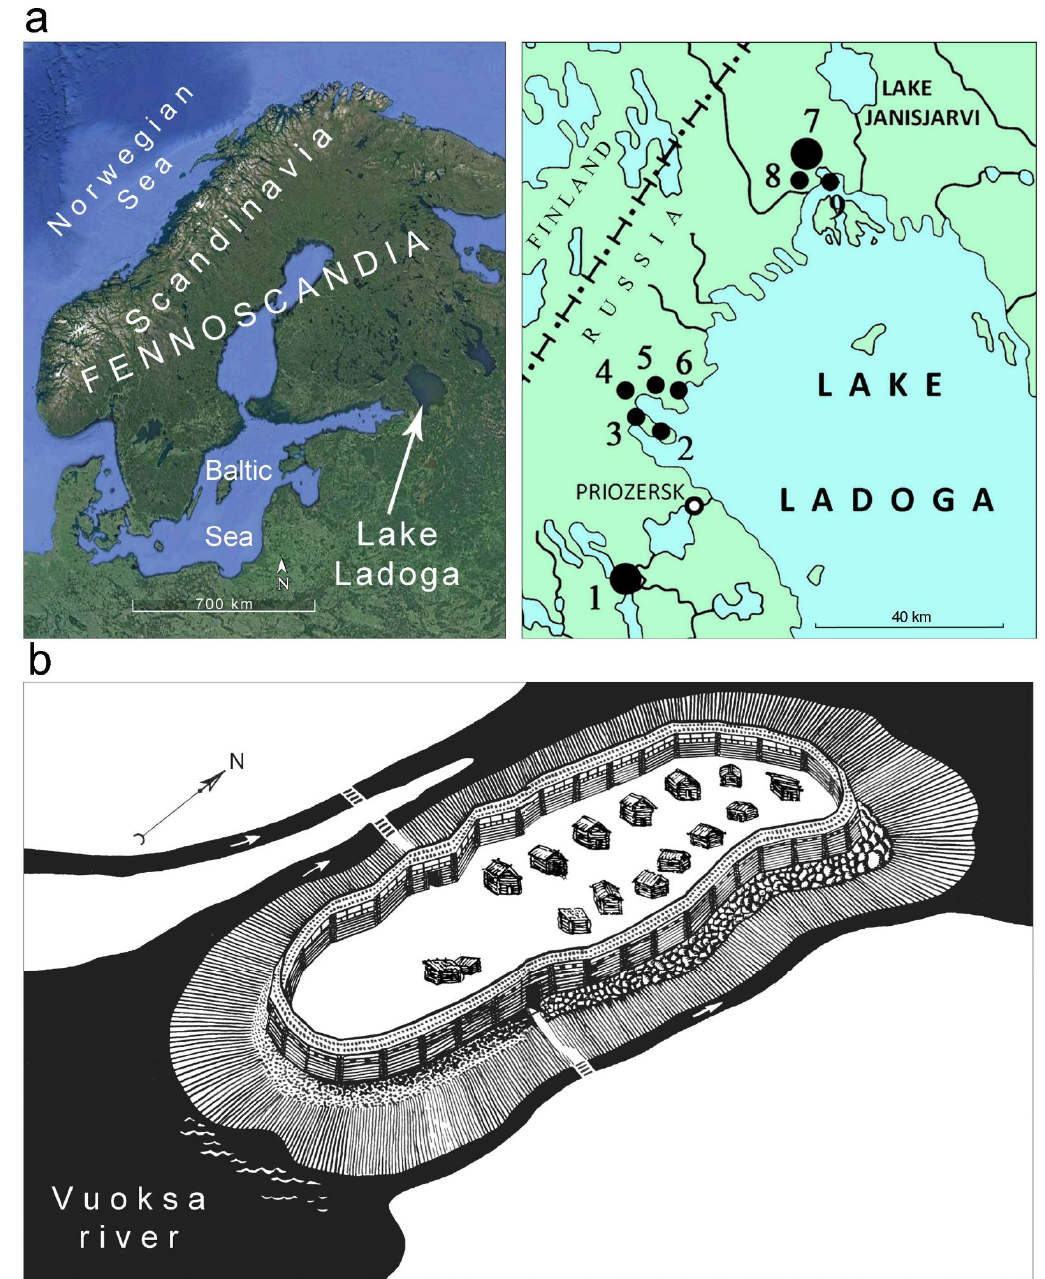
Figure 1. ( a ) Maps showing Lake Ladoga and the medieval Karelian hillforts: 1—Tiversk; 2—Rantalinnamyaki; 3—Khyameenlakhti-Linnavuori; 4—Lopotti-Linnamyaki; 5—Soskua-Linnamyaki; 6—Tervu-Linnasaari; 7—Paaso; 8—Rautalakhti-Linnavuori; 9—Tokkarlakhti-Linnasaari. ( b ) Graphic reconstruction of the Tiversk hillfort by S.I. Kochkurkina and V.A. Bazegskiy [37] (pp. 18–19). The larger markers ( a ) stand for sites where more than 1000 m 2 was excavated; the smaller ones stand for excavations less than 1000 m 2 . The bicolor mark of modern Priozersk points at the place of the Korela fortress location.